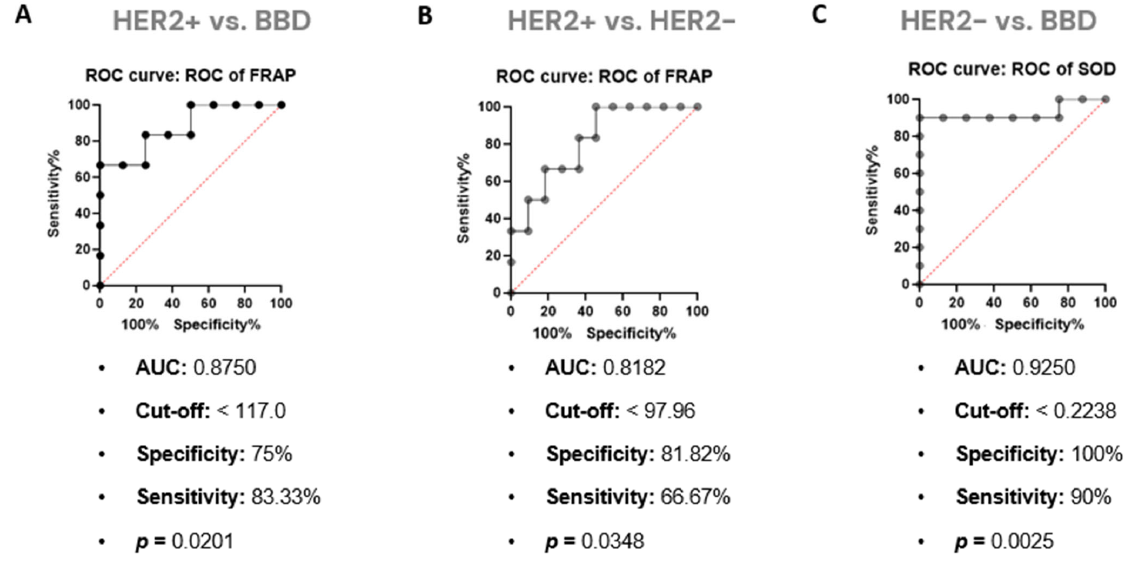
Figure 5. ROC Curve for HER2+ vs. BBD, HER2+ vs. HER2 − and HER2 − vs. BBD. ( A ) FRAP differentiates the groups HER2+ and BBD; ( B ) FRAP differentiates the groups HER2+ and HER2 − ; ( C ) SOD differentiates the groups HER2 − and BBD. The SOD enzyme level presented a cut ‐ off point <0.2238 from which discriminates the HER2 − BC group from the BBD group (100% specificity and 90% sensitivity). 3.4. FRAP Strongly Correlates and Affects Results Obtained by ATR ‐ FTIR in Serum Samples from Women with HER2+ BC Based on the previous results, we proceeded to investigate whether the absorbance relative to the wavenumbers in the ATR ‐ FTIR that are different between the HER2+ and BBD groups (3874 cm − 1 , 3876 cm − 1 , and 3878 cm − 1 ) are influenced by redox status markers GSH, SOD, CAT, FRAP, and carbonylated protein. Among the redox status markers evaluated, only FRAP impacts the absorbance value obtained at wavenumbers 3874 cm − 1 ( β = − 0.038; p < 0.001), 3876 cm − 1 ( β = − 0.059; p < 0.001) and 3878 cm − 1 ( β = − 0.066; p < 0.001) of the HER2+ BC infrared spectrum. Regarding the BBD group, the SOD level affected the absorbance value obtained at wavenumbers 3874 cm − 1 ( β = 13.525; p = 0.034), 3876 cm − 1 ( β = 18.571; p = 0.001) and 3878 cm − 1 ( β = 24.565; p = 0.042). No markers studied showed influence on the ATR ‐ FTIR infrared spectrum obtained from serum samples from women with HER2 − or the general BC group. To determine whether there is a correlation between the redox status markers and the absorbance values of the selected wavenumbers, statistical analyzes were performed. Using Spearman’s correlation, a correlation between FRAP level and the regions of the spectrum 3874 cm − 1 (r = 0.829; p = 0.042), 3876 cm − 1 (r = 0.829; p = 0.042), and 3878 cm − 1 (r = 0.829; p = 0.042) was found for the HER2+ BC group. However, for the BBD group, no such correlations occur for FRAP [3874 cm − 1 (r = 0.143; p = 0.736), 3876 cm − 1 (r = 0.190; p = 0.651) and 3878 cm − 1 (r = 0.119; p = 0.779)] or for the other redox status markers.